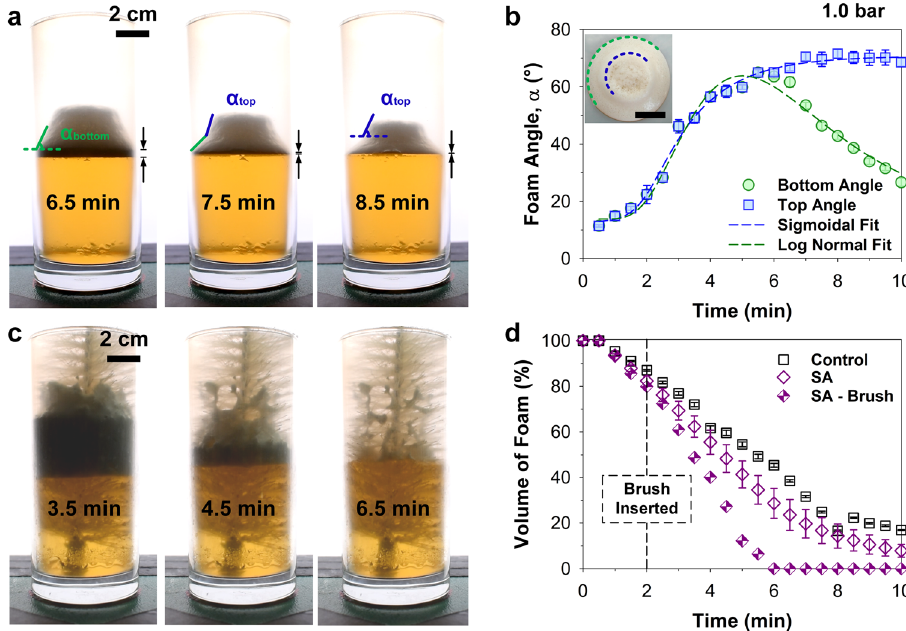
Fig. 5 Importance of foam-to-surface contact for defoaming. a The foam-to-surface contact line recedes from the superamphiphobic (SA) surface due to rapid destabilization. An angular cone-like structure fi rst evolves, bearing a single angle. a , b The single angle degrades into two distinctive angles during continued defoaming of the volumetric bulk. Inset — top view, scale bar: 2 cm. c A three-dimensional volumetric defoamer was synthesized using a high surface area template, i.e., a brush coated with the superamphiphobic coating. This was compared to the original superamphiphobic and control systems. c , d The superamphiphobic volumetric defoamer experienced up to 40 – 50% defoaming enhancement vs . the control. Dispensing pressure: 1.0 bar using contrasted backlighting. All data are presented in mean ± standard